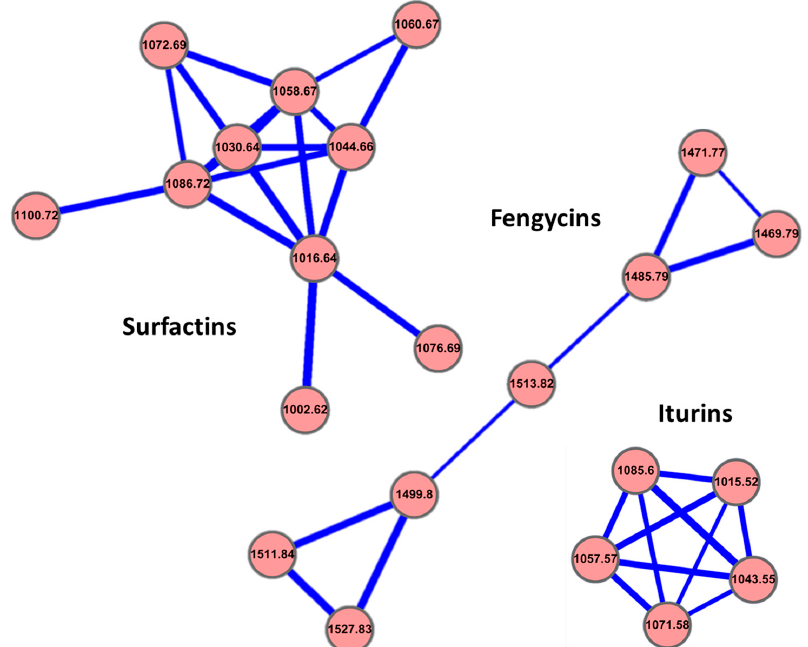
Figure 2. Molecular networking of lipopeptide family clusters produced by Ba-BPD1 in LB medium. The lipopeptides were grouped into three clusters: surfactins, iturins, and fengycins. Values of m/z [M + Na] + were used to present each group of lipopeptides.